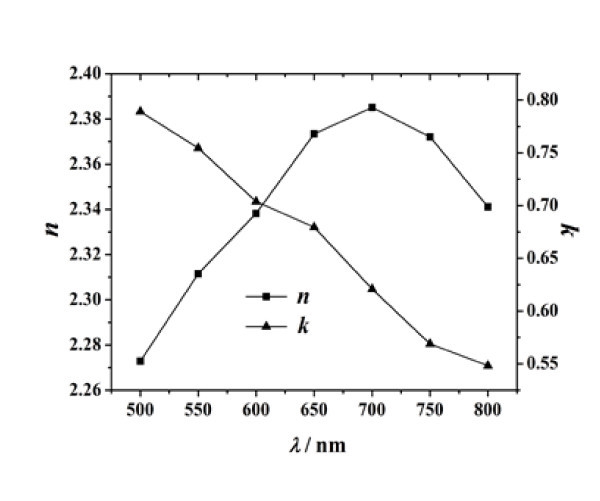
Refractive index n and extinction coefficient k of Fe3O4.